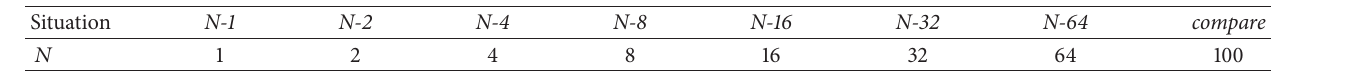
Table 8: Parameter list of different sampling numbers.